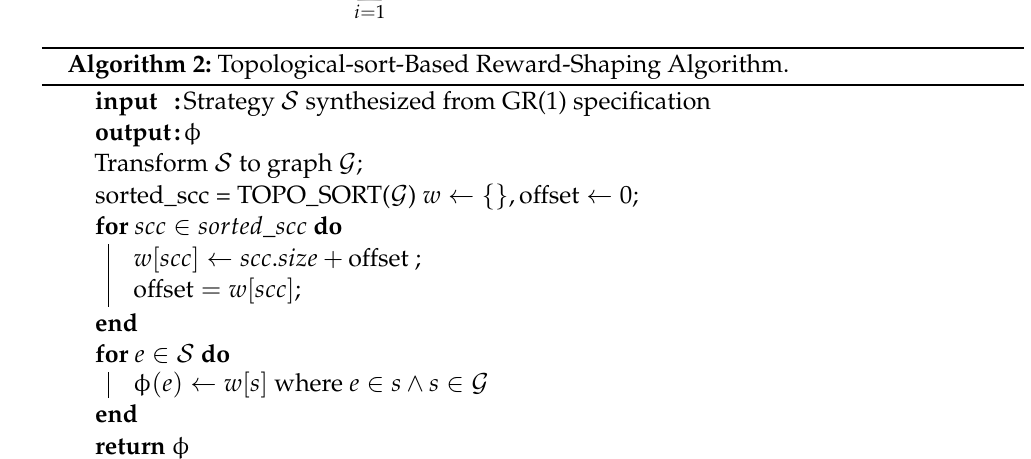
Algorithm 2: Topological-sort-Based Reward-Shaping Algorithm.